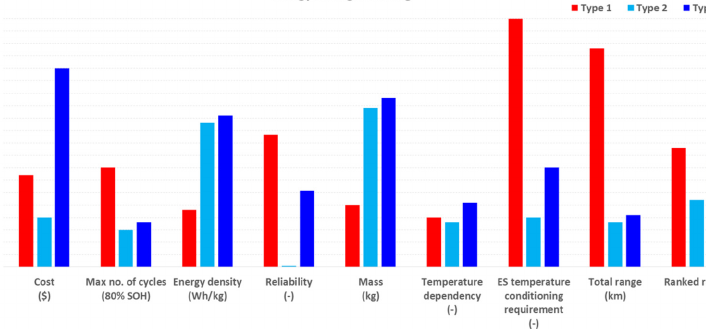
Figure 20. Ranking of energy storage types. Table 9. Energy storage types summary